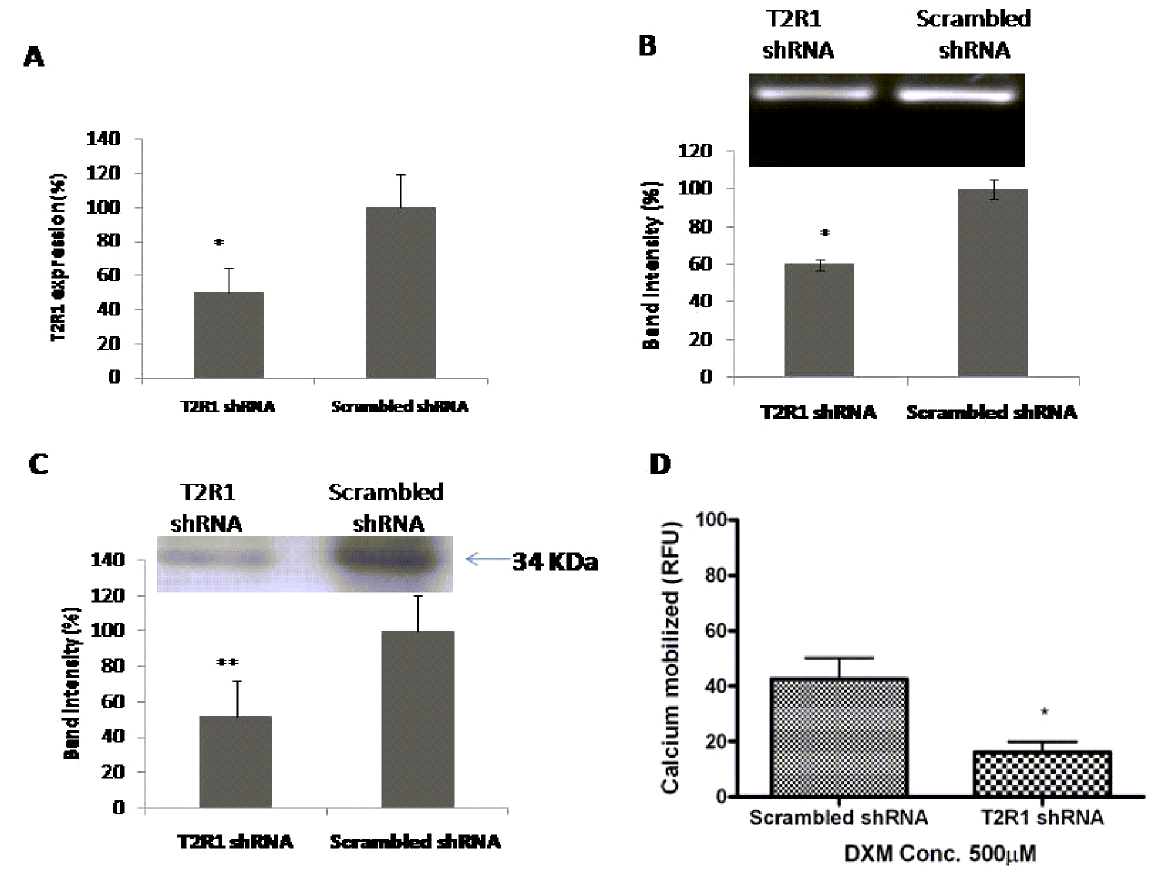
Figure 3. Knockdown of T2R1 in hPASMCs. A . Primary cultures of hPASMCs were transfected with scrambled shRNA (control) or shRNA T2R1. 48 h post-transfection, cells were used for RNA extraction and real-time PCR. Results are normalized to GAPDH expression. Percentage (%) knockdown efficiency was computed using 2 2 DD CT method. Values are mean 6 SEM, n=5. Statistical significance was determined by student t -test, *p , 0.05 vs scrambled shRNA (control). B . Representative agarose gel analysis of figure 3A. Lane 1 represents T2R1-shRNA and lane 2 scrambled shRNA. Quantification of T2R1 knockdown is represented via bar graph using the densitometric analysis. Statistical significance was determined by student t -test, *p , 0.05 vs scrambled shRNA. C . Western blot analysis showing T2R1 knockdown at the protein level in hPASMCs. Band intensity was normalized to expression of b -actin. Bar graph shows the quantitative analysis of receptor knockdown in the blot. Statistical significance was determined by student t -test, **p , 0.01 vs scrambled shRNA (control). D . Functional effects of T2R1 knockdown in hPASMCs. hPASMCs were transfected with scrambled shRNA (control) and shRNA T2R1. 48 h post-transfection, cells were used for calcium mobilization experiment, and stimulated with 500 m M DXM. Data were collected from five independent experiments carried out in triplicate. Values are mean 6 SEM, n=5. Statistical significance was determined by student t -test, *p , 0.05 vs scrambled shRNA (control).